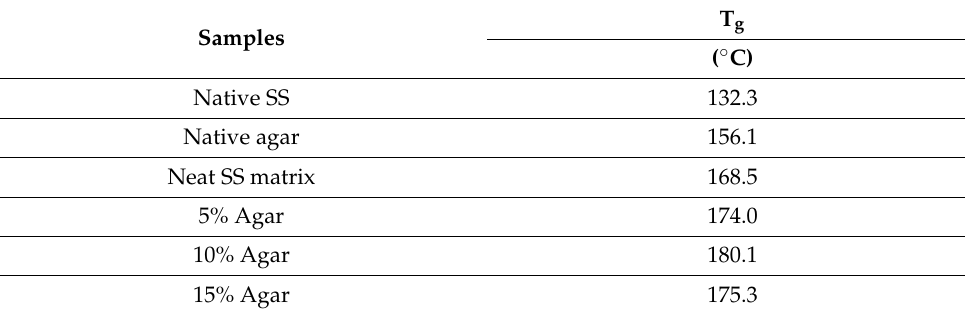
Table 3. Glass transition, T g of